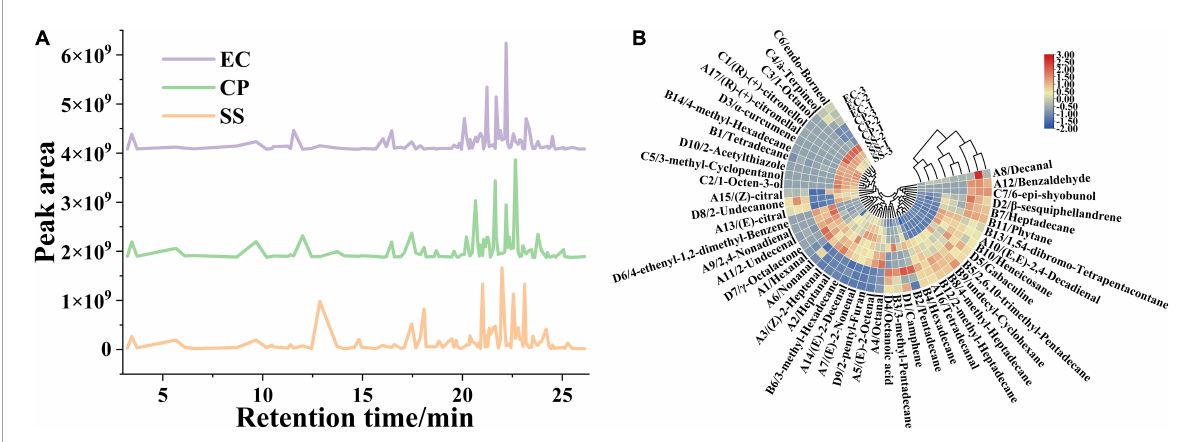
FIGURE4 Effects of cooking mode on the area of peaks for flavor substances from the Clitocybe squamulose chicken soup (A) , and heat map obtained from cluster analysis of flavor substances in Clitocybe squamulose chicken soup with different cooking mode (B) . The color in heat map represented the relative concentration of flavor substance, the gradual color change from red to blue indicated the concentration change from high to low.